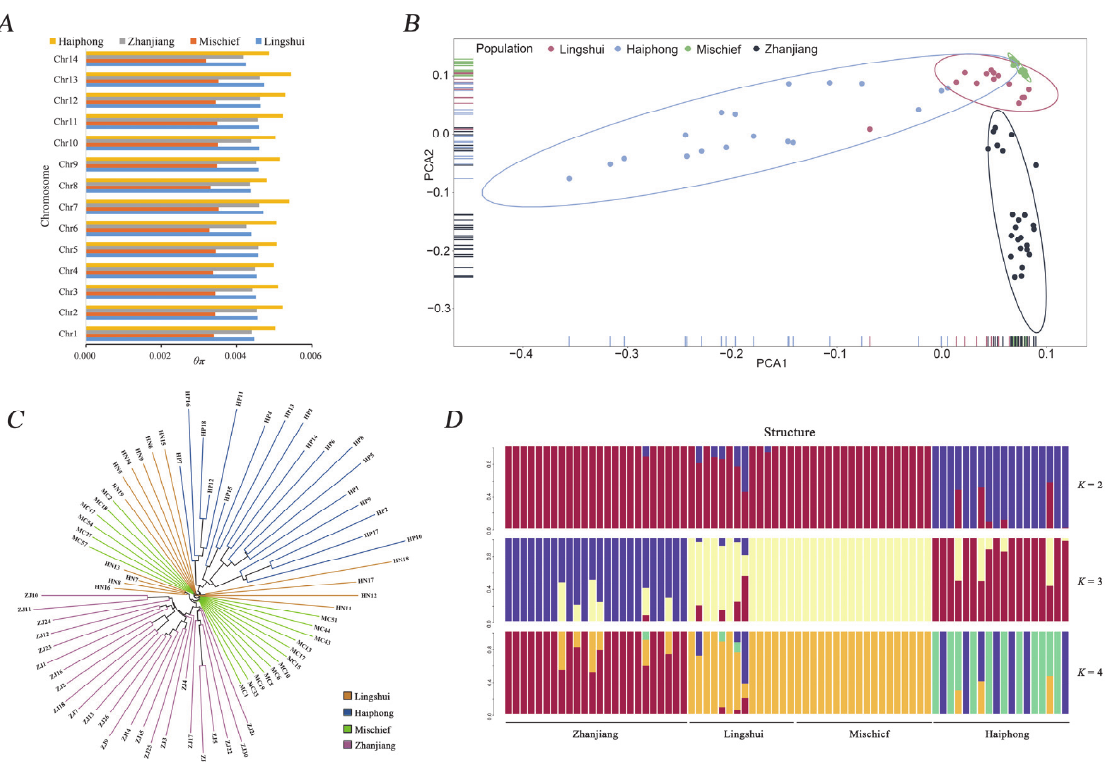
Figure 2. Population genetic diversity and structure of four P. fucata populations. ( A ). θ π values of different chromosomes of the four P. fucata populations. ( B ). PCA plot of the first two principal components based on all SNPs. ( C ). The neighbor-joining phylogenetic tree of all samples. ( D ). The structure analysis graph under different K values.